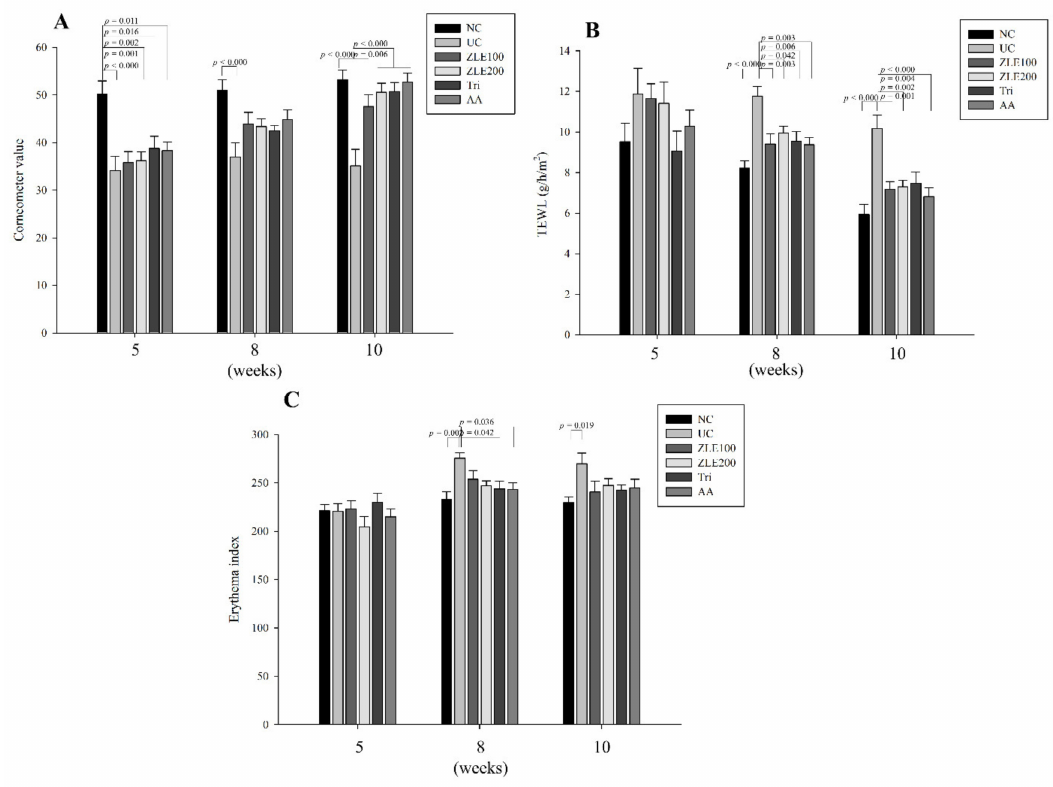
Figure 6. E ff ects of enzyme-treated Z. latifolia extract (ZLE) and tricin on dermal moisture content, transepidermal water loss (TEWL) and the dermal erythema index of UVA-irradiated mice dorsal skin. ( A ) Dermal moisture content, ( B ) TEWL and ( C ) dermal erythema index. Data are expressed as the mean ± SE. The p values are determined by ANOVA and Tukey’s HSD